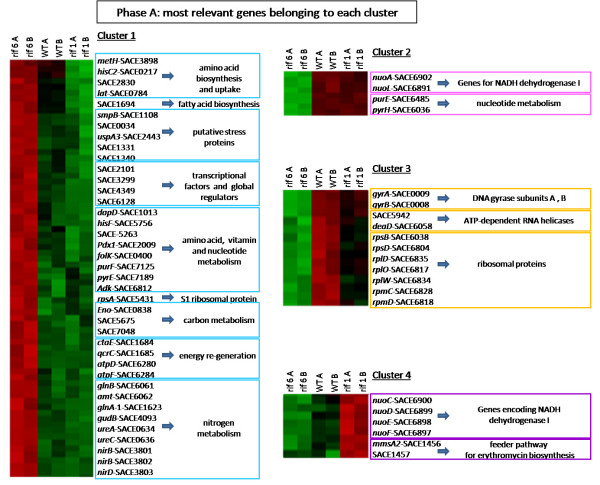
Microarray analysis of the most relevant DEGs. Visualization by dChip of the most relevant genes belonging to each of the four clusters formed by phase a-DEGs. Red = up-regulation; Green = down-regulation.